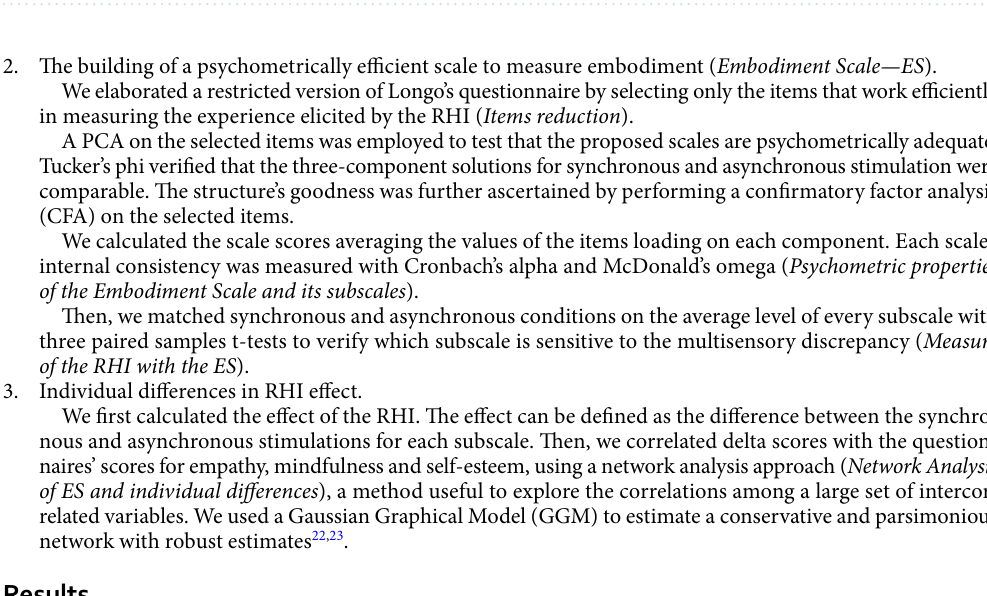
Figure 1. Scree-plot of the PCA on the 27 items after synchronous condition. The eigenvalues are reported in the table below the graph. The black dots represent the eigenvalues of each component in decreasing order calculated on the real data. The red line shows the simulated data of the parallel analysis. Components above the red line are those indicated by the parallel analysis. The gap after the third component in the scree-plot suggests considering a three-components